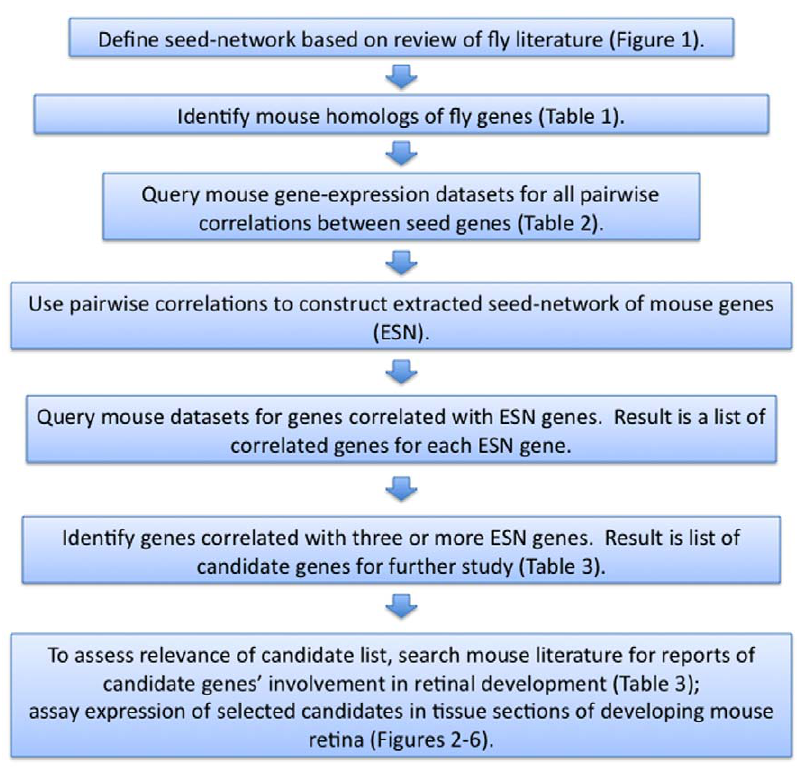
Figure 7. A description of our biological heuristic strategy.